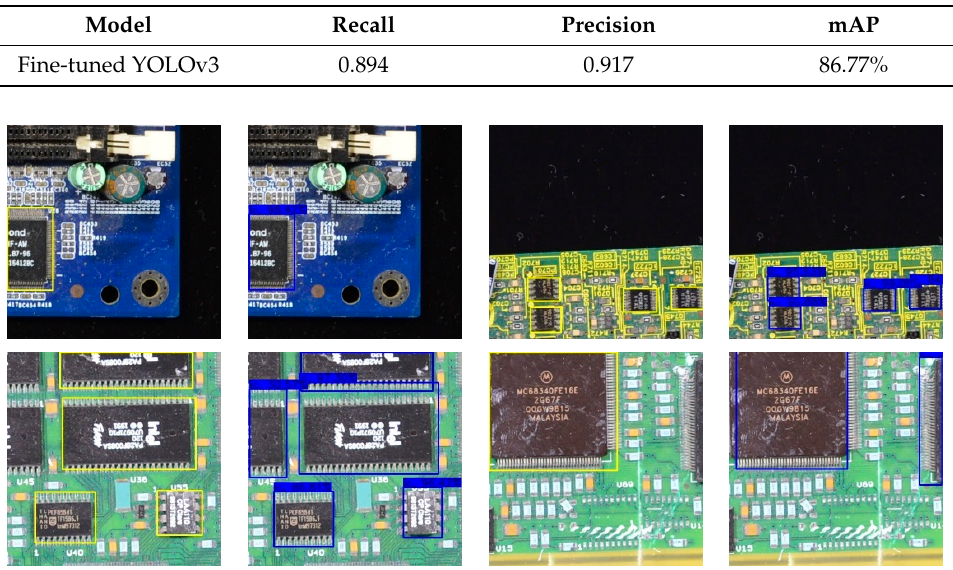
Table 3. Precision, Recall, and mAP for the IC detector model.